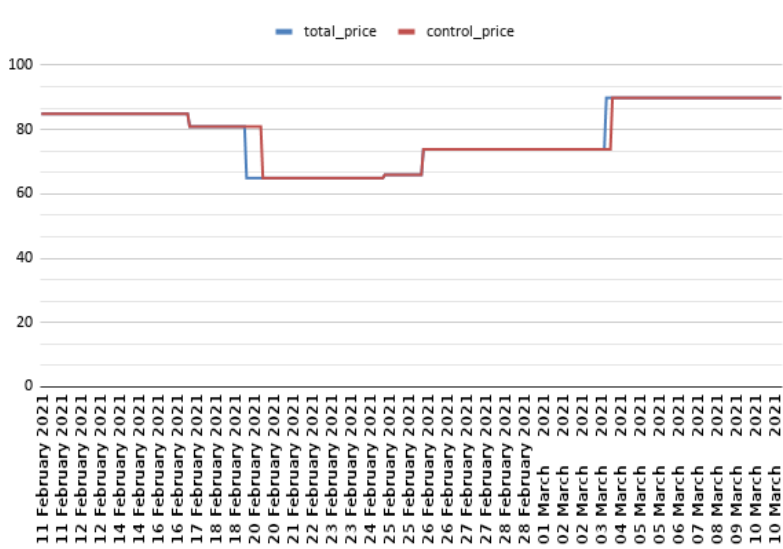
Figure 3. Alitalia price chart.